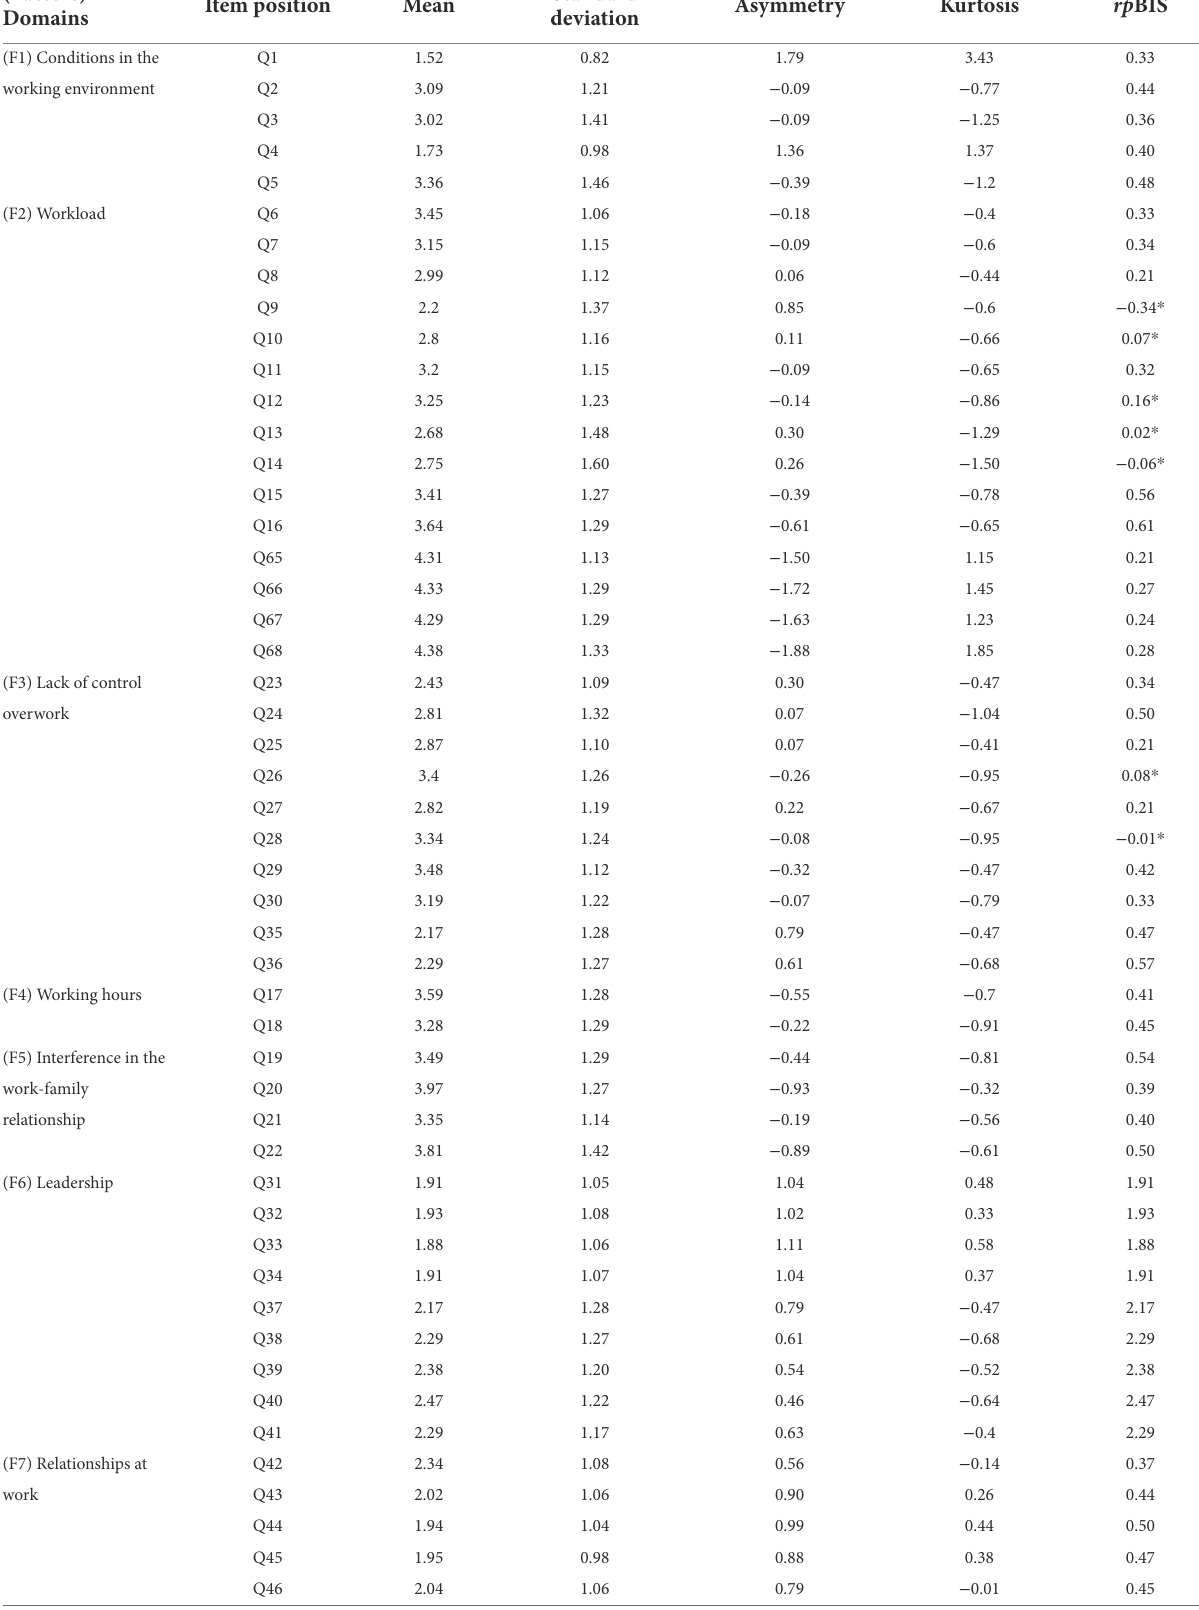
TABLE 3 Descriptive statistics of the General Index (GI) of the IIA-PRF and by item. (Factors) Item position Mean Domains